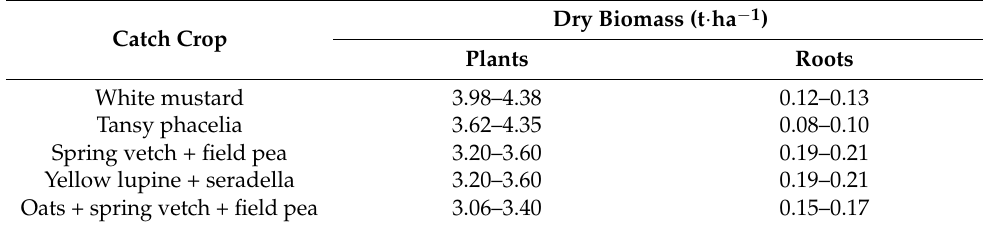
Table 12. Average yield of catch crop dry matter